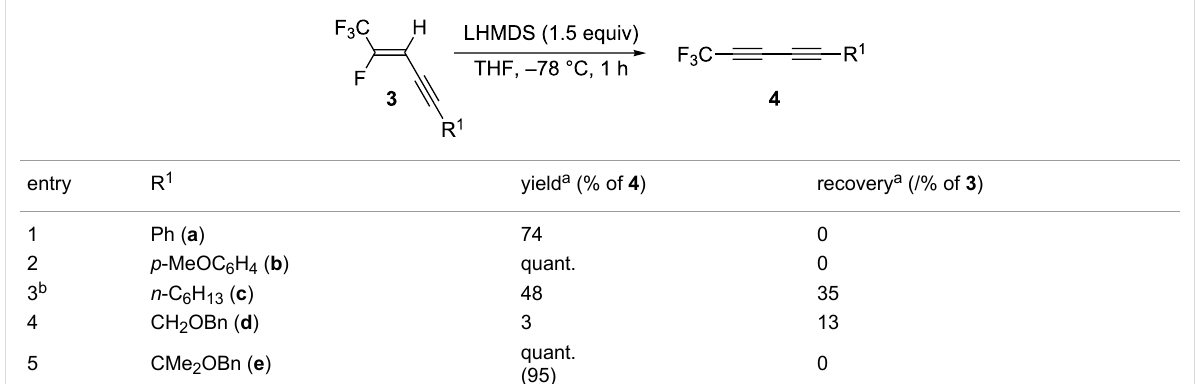
Table 2: β -Elimination of various